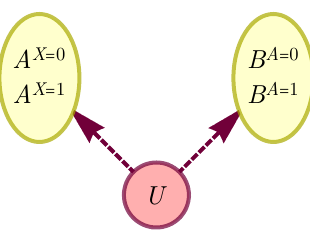
Figure 12: The unpacking of the instrumental